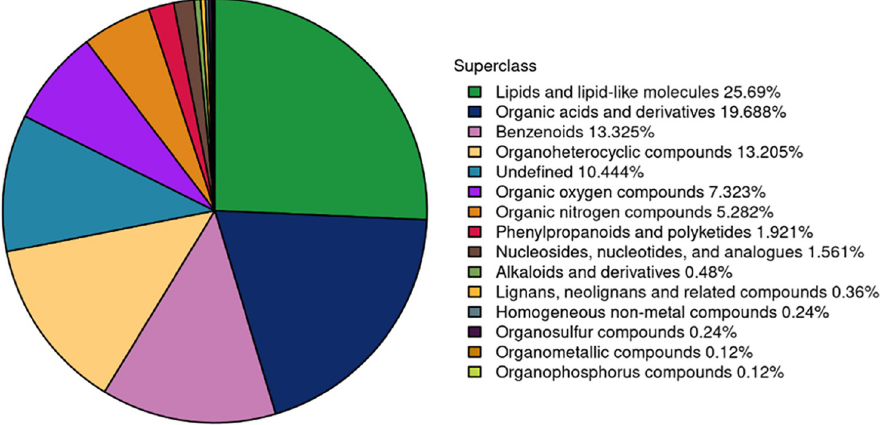
Fig 2. Chemical superclasses of biofloc-derived